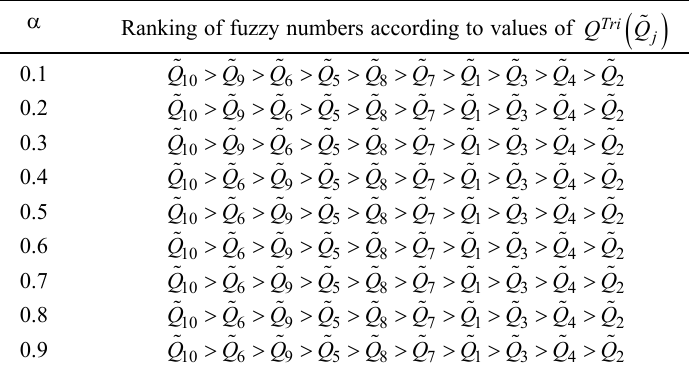
Table 10. The ranking of